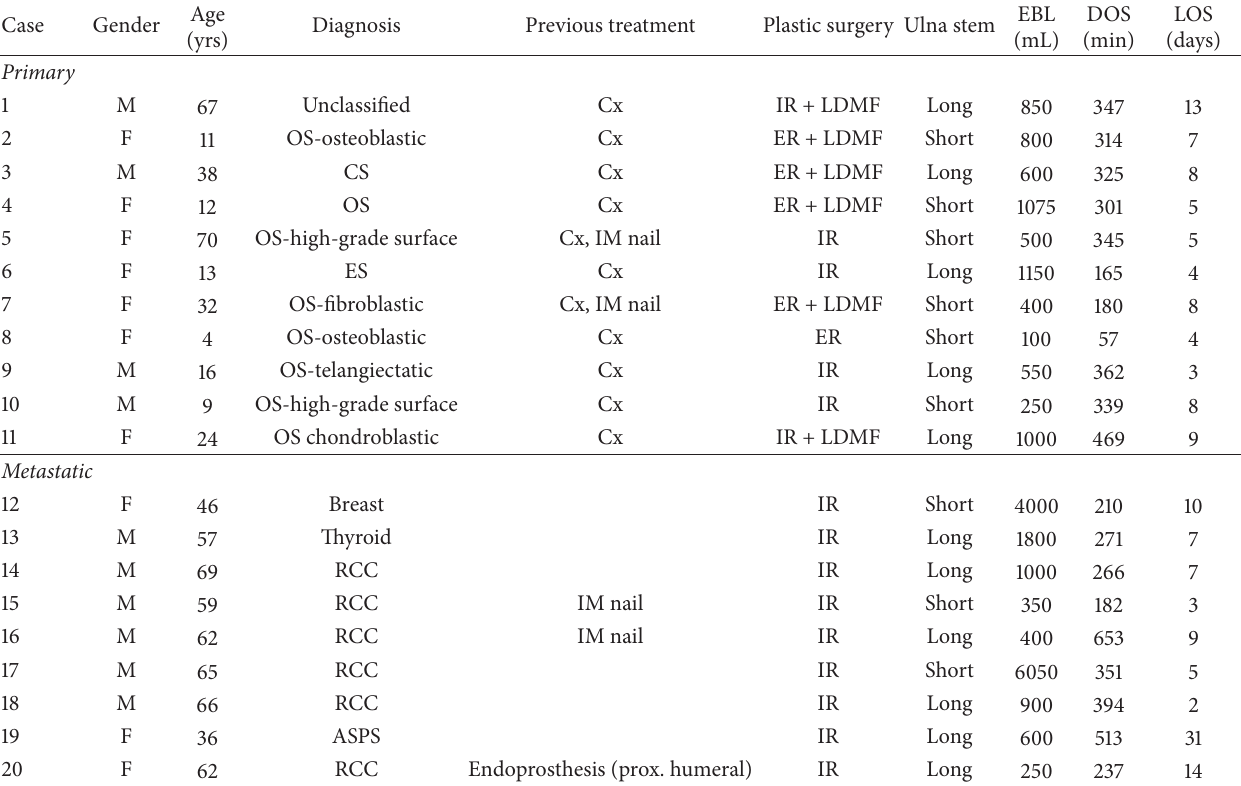
Table 1: Demographics and surgical